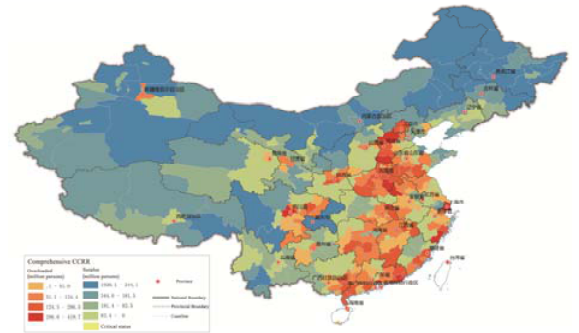
Figure 3. Carrying capacity of relative natural resources in China